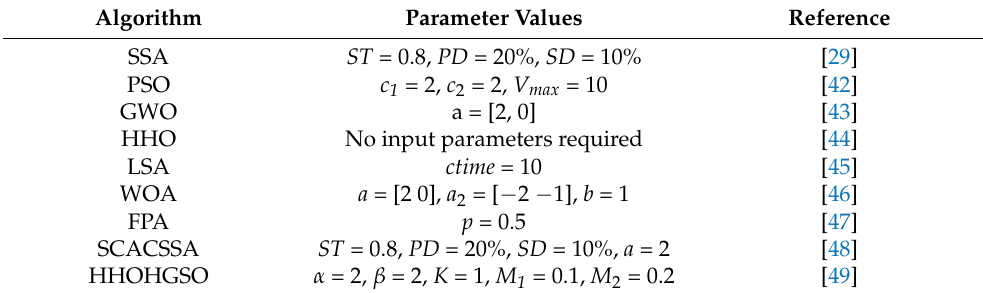
Table 2. The parameter values of different experiments.